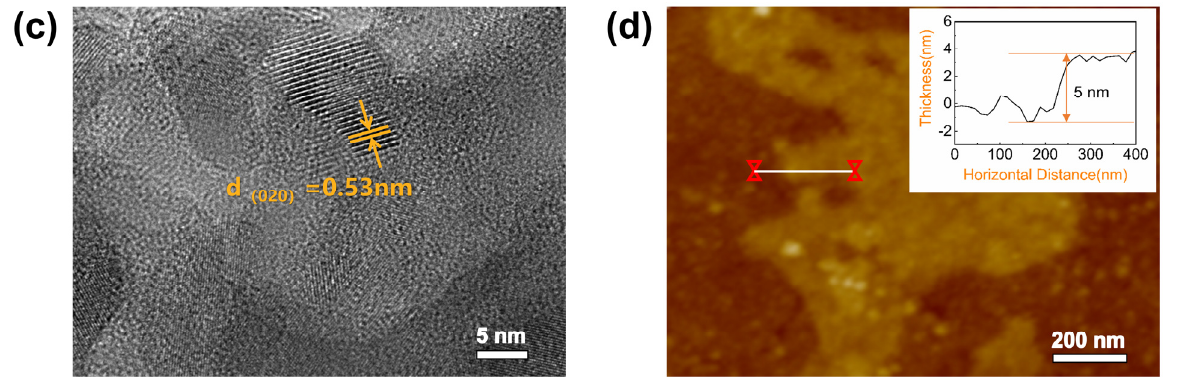
Figure 4. The Raman spectra ( a ) and X-ray diffraction ( b ) of RP and BP nanosheets; the HR-TEM image ( c ) and AFM image ( d ) of the BP nanosheets.